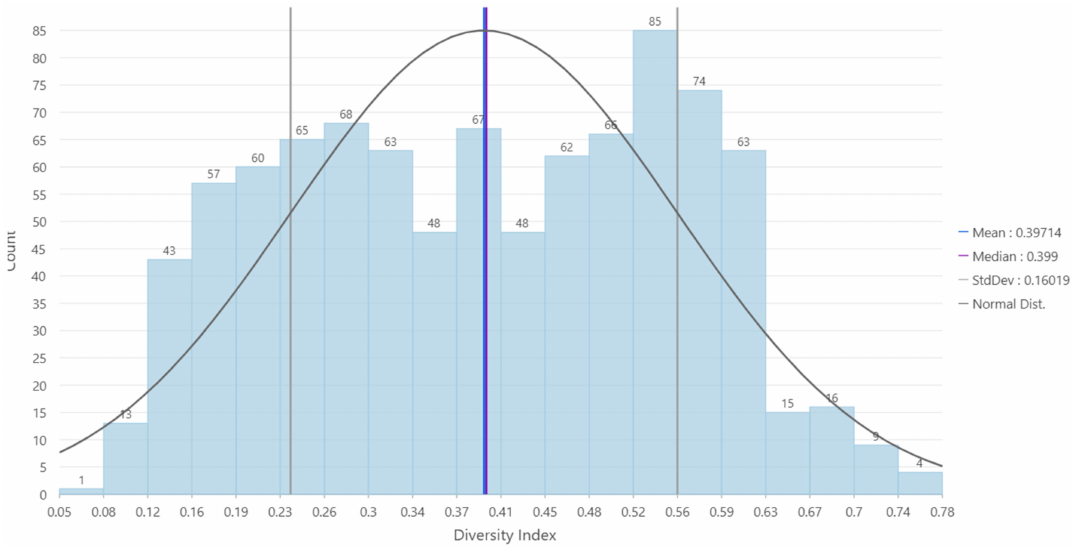
Figure 8. Histogram of Racial diversity Indices, Metro/Micro Areas,